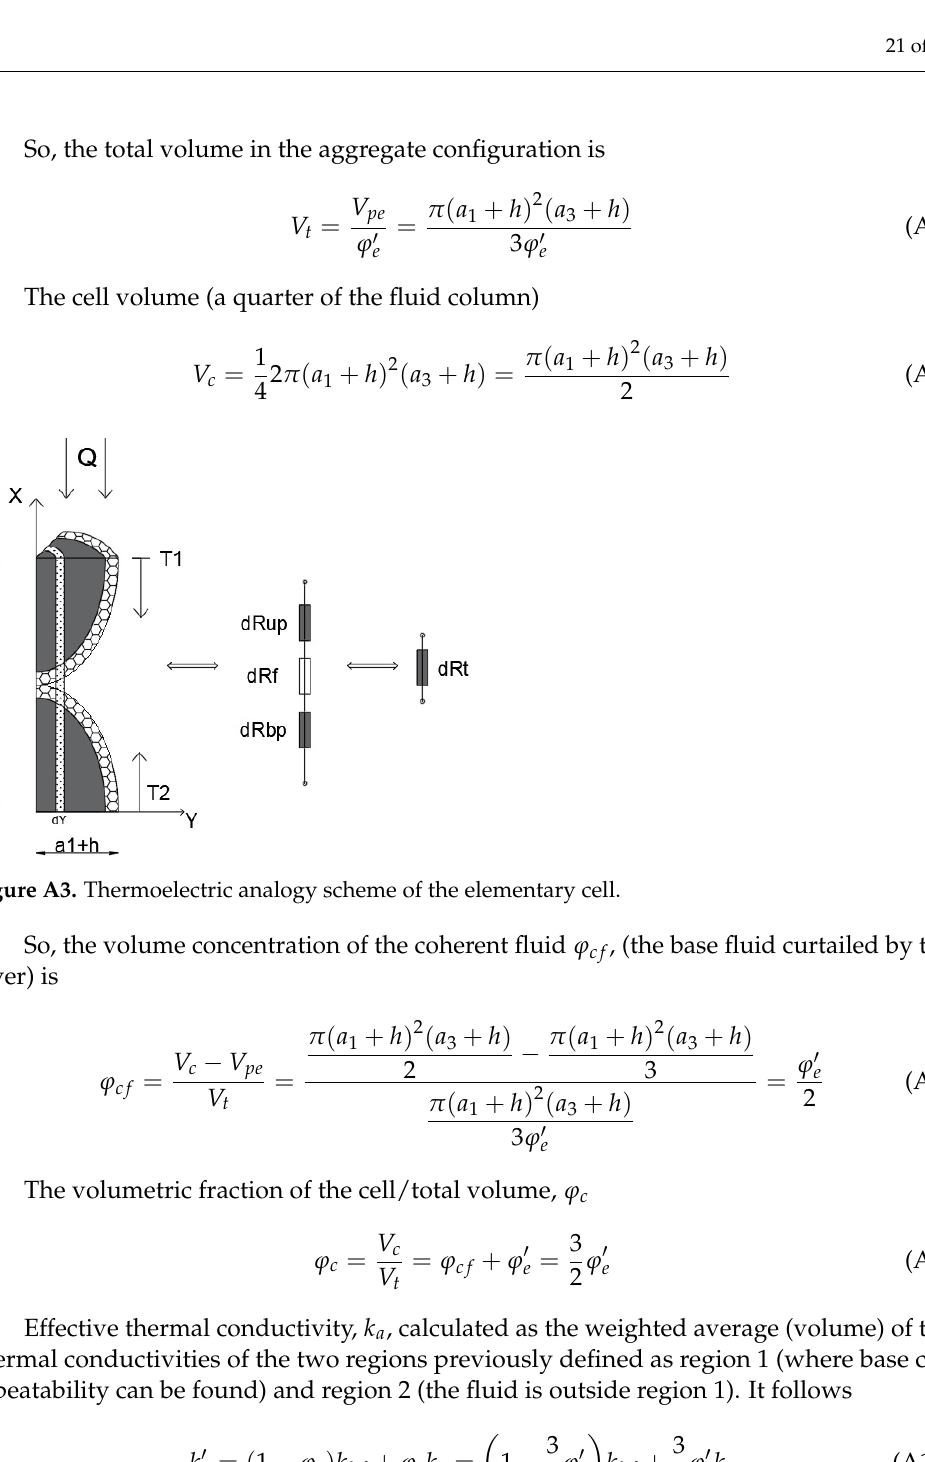
23 of 27 Figure A2. Configurations of equivalent particles